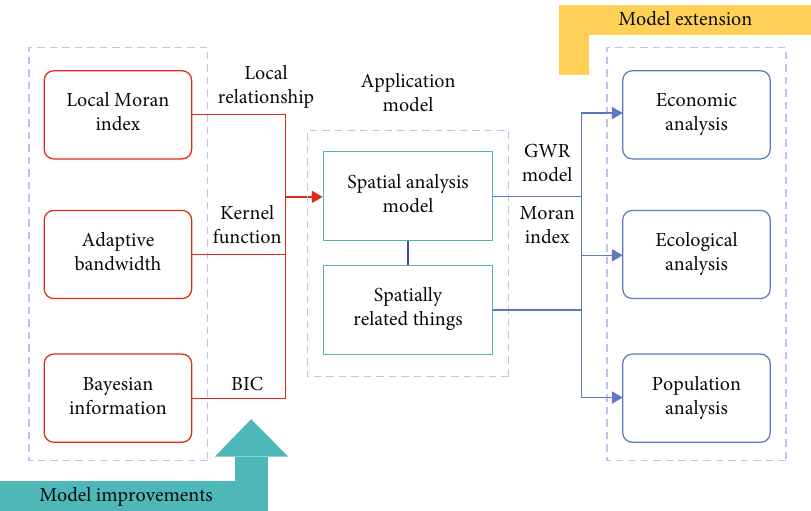
Figure 10: Model improvements and